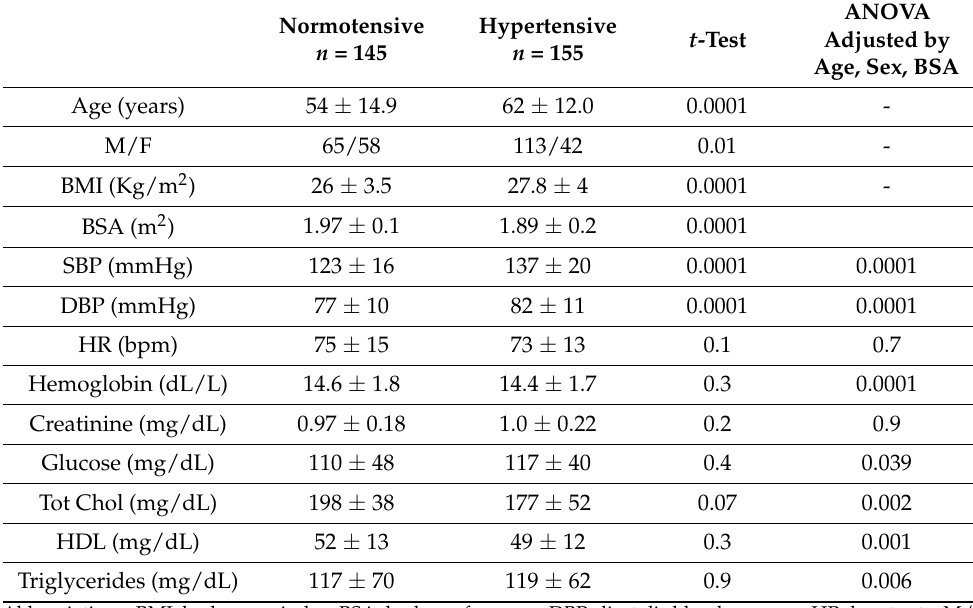
Table 1. General characteristics in normal and hypertensive